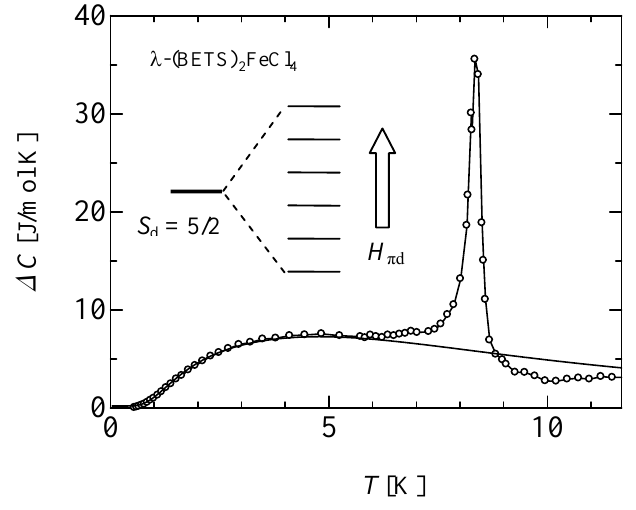
Figure 2. Excess specific heat Δ C of λ-BETS electric specific heat estimated for λ-BETS specific heat based on the paramagnetic 3 d spin (Fe 3+ s magnetic field H = 4.0 T. The inset shows the energy levels of s πd splitting. Reproduced with permission from JPSJ